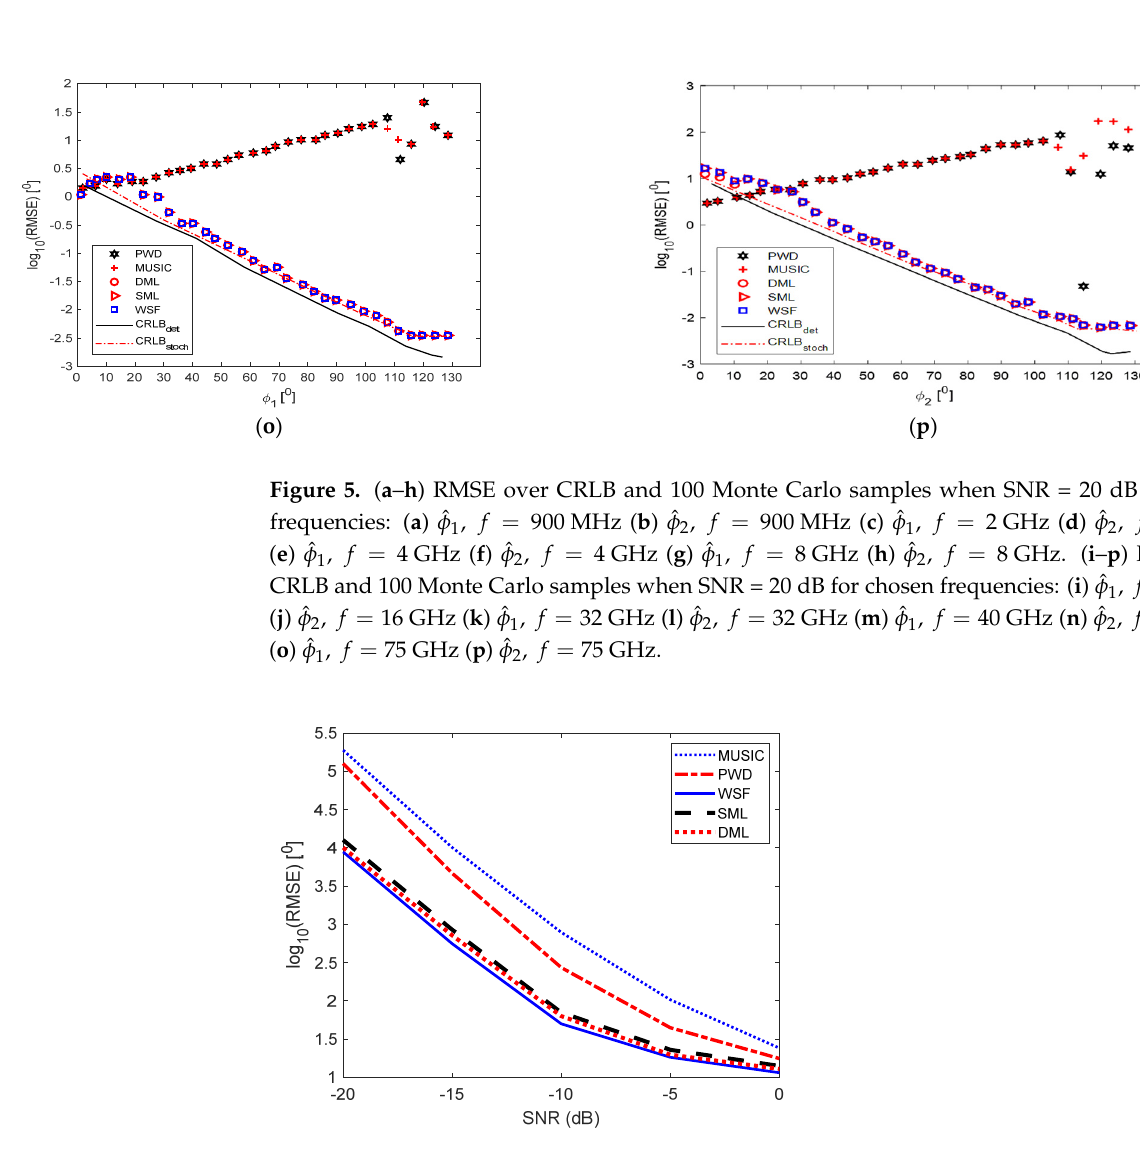
Figure 6. RMSE versus SNR comparison test between MUSIC, PWD, DML, SML, and WSF.